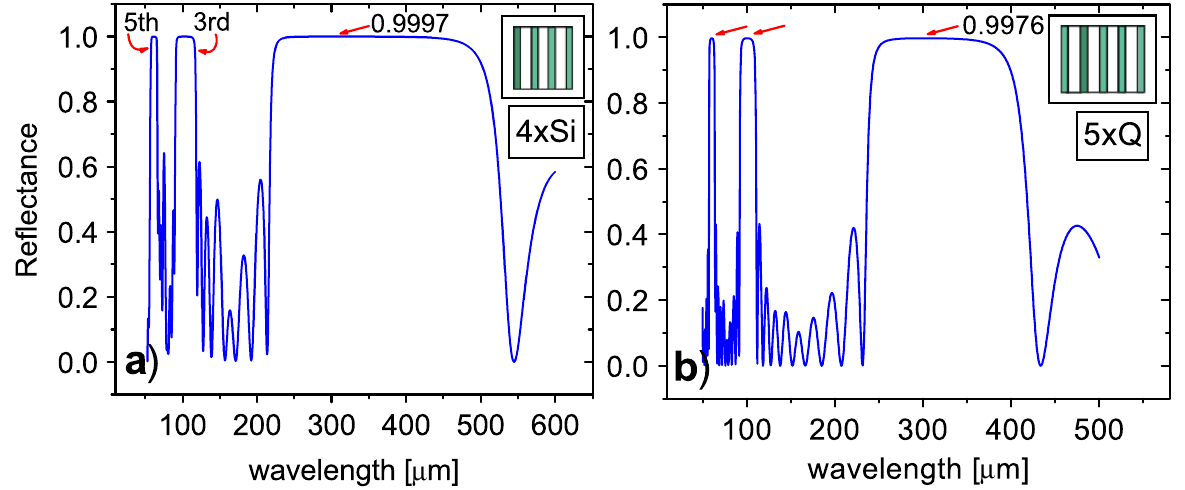
FIG. 2. (Color) In (a) four layers of 23 (cid:6) m thick Si, and in (b) five layers of 36 (cid:6) m thick z-cut quartz, each separated by 75 (cid:6) m vacuum gap, create high reflectivity bands centered at (cid:2) (cid:1) 60 (cid:6) m , respectively.